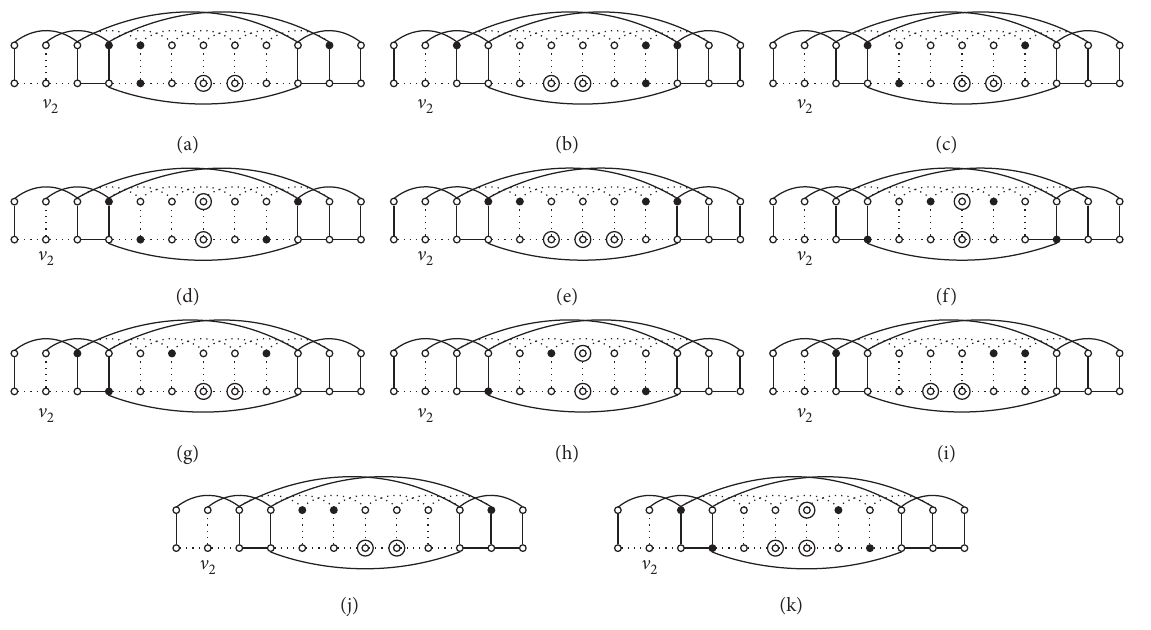
Figure 5: The eleven possible cases of S in Subcase